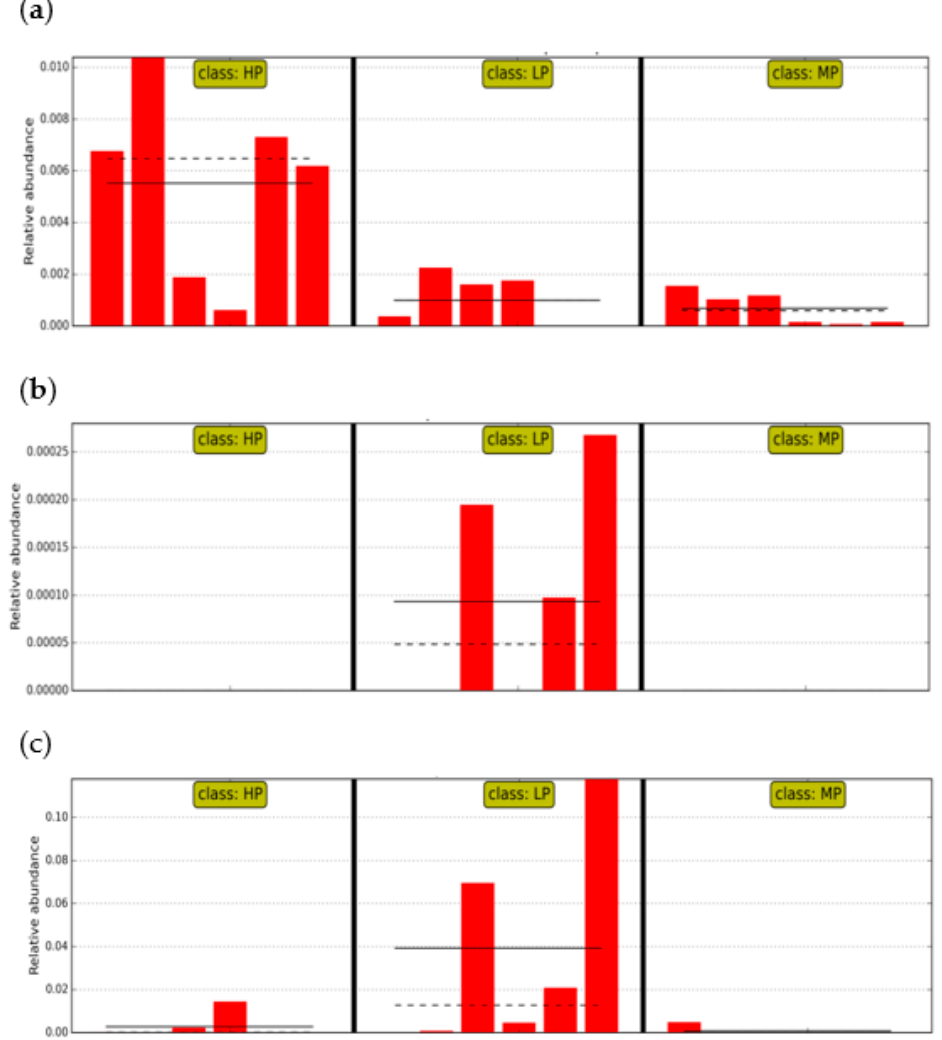
Figure 4. The relative abundance of taxa with significant differences in different groups at the genus level. ( a ) Clostridium ; ( b ) Enterovibrio ; ( c ) Grimontia .